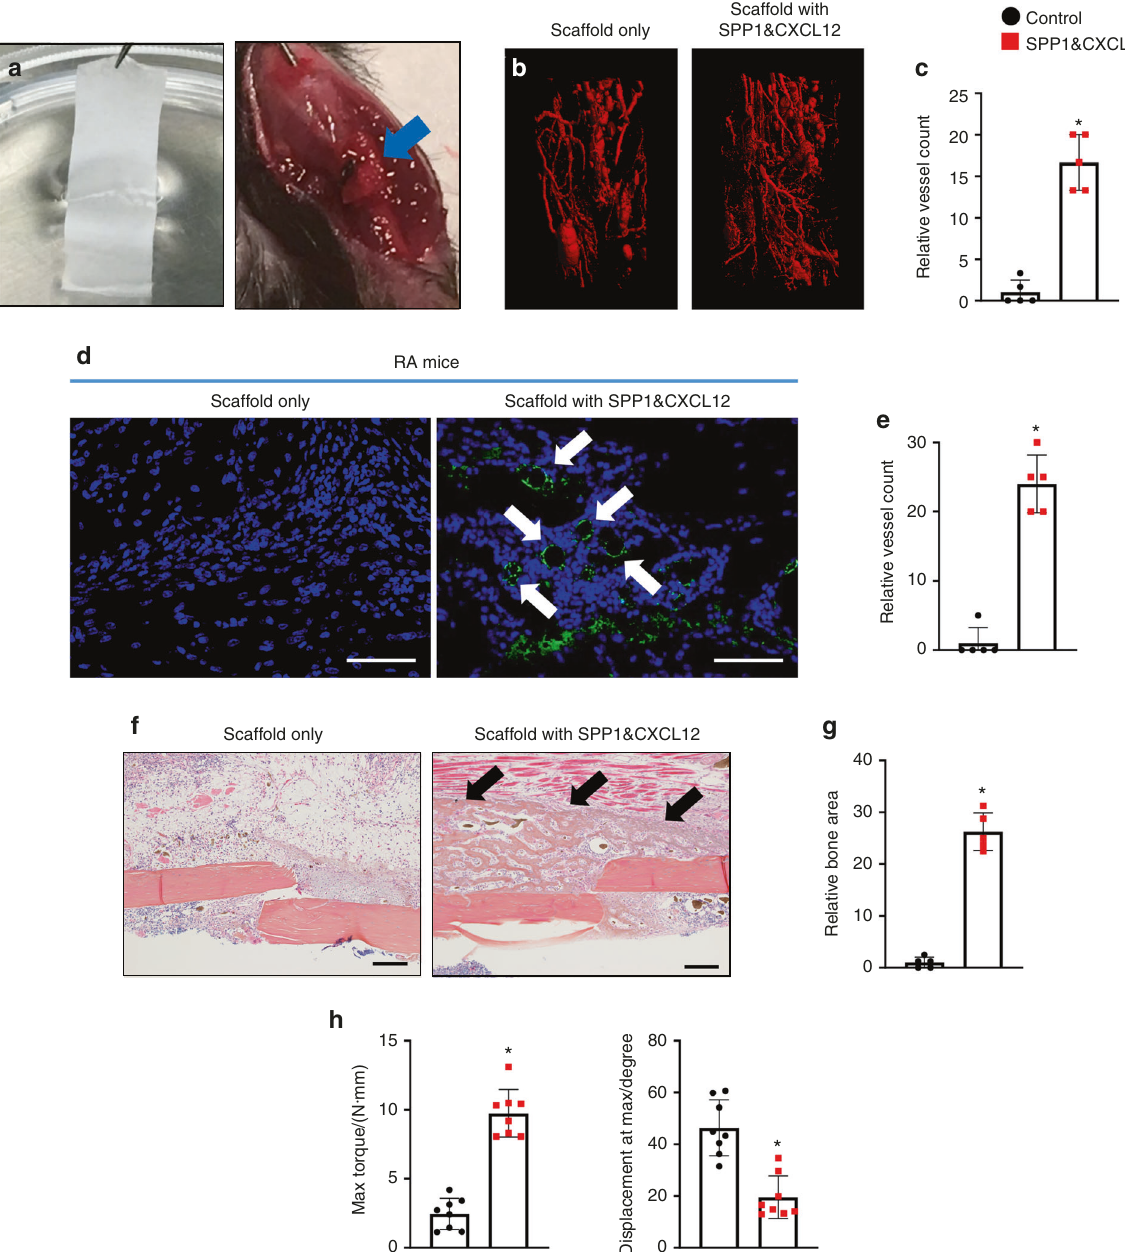
Fig. 6 The controlled release of SPP1 and CXCL12 restored angiogenesis and fracture nonunion in RA mice. a PCL scaffold with or without SPP1 and CXCL12 was applied to the fractured bone in RA mice. b MicroCT assessment of newly formed vessels within fracture calluses from RA mice treated with scaffolds with or without SPP1 and CXCL12 ( n = 5) at 10 dpf. c Quanti fi cation of the vessels in RA fracture calluses ( n = 5) at 10 dpf based on microCT assessment. The results were normalized to the scaffold only group. * P < 0.05 compared with control by Student ’ s t- test. d Immunohistochemical staining for endomucin in fracture calluses from RA mice at 10 dpf. e Quanti fi cation of the vessels in RA fracture calluses at 10 dpf ( n = 5) based on the immunohistochemical assessment. The results were normalized to the scaffold only group. * P < 0.05 compared with control by Student ’ s t test. f Representa t ive ABH/OG staining of fracture callus sections from RA mice treated with scaffold with or without SPP1 and CXCL12 at 10 dpf ( n = 5). g Histomorphometric quanti fi cation of bone area was performed on 10 dpf fracture callus sections from RA mice treated with scaffolds with or without SPP1 and CXCL12 ( n = 5). The results were normalized to the scaffold group. h Biomechanical torsion testing of RA fractures treated with scaffold with or without SPP1 and CXCL12 at 28 dpf ( n = 8). Max torque and displacement at max were quanti fi ed. All results were normalized to the controls. * P < 0.05 compared with control by Student ’ s t test. Scale bar, 200 μ knockout of either Spp1 50 or Cxcl12 49 alone was shown to lead to attract macrophages and function synergistically with other cytokines derived from macrophages to promote angiogenesis. 70 angiogenesis defects and impaired fracture healing in mice, indicating the positive role of SPP1 and CXCL12 in angiogenesis Similarly, CXCL12 recruits CXCR4-positive endothelial cells and and fracture healing. Interestingly, there is increasing evidence that facilitates angiogenesis. 71 In regard to fracture healing, global